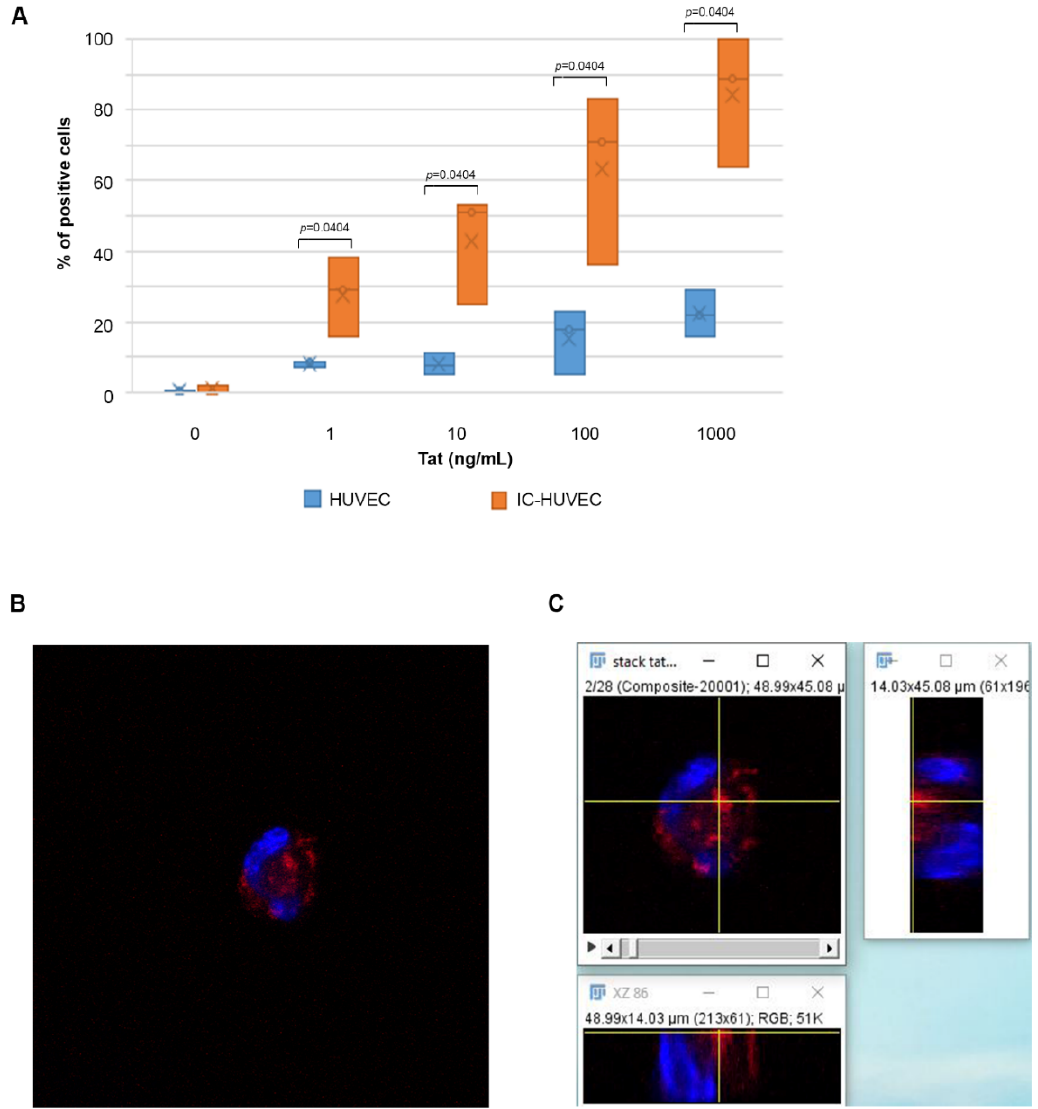
Figure 1. Extracellular Tat protein is efficiently taken up by activated endothelial cells. In ( A ) human umbilical vein endothelial cells (HUVEC, blue plots) or inflammatory cytokine (IC)-activated (IC-HUVEC (orange plots) were incubated for 10 min in medium containing serial concentrations (1–1000 ng/mL) of biologically active Tat or its suspension buffer (PBS-0.1% BSA). Intracellular Tat content was evaluated by flow cytometry after staining with affinity-purified rabbit anti-Tat polyclonal Ab (or isotype control), as described in Section 4 Materials and Methods. Non-permeabilized cells were employed as an additional control. Results are expressed as the percentage of positive cells, as compared to isotype-stained samples. Box-plot of data obtained from three independent experiments and analyzed by the Mann–Whitney nonparametric test are shown. Dots indicate individual measures. In ( B , C ), IC-HUVEC were incubated with rhodamine-labeled Tat (100 ng/mL) and treated as described in Section 4 Materials and Methods. Images are optical sections (optical thickness = 0.40 μm) collected from a confocal microscope showing cellular internalization of Tat (red). Blue indicates nuclei stained with DAPI. Scale bar = 15 μm.